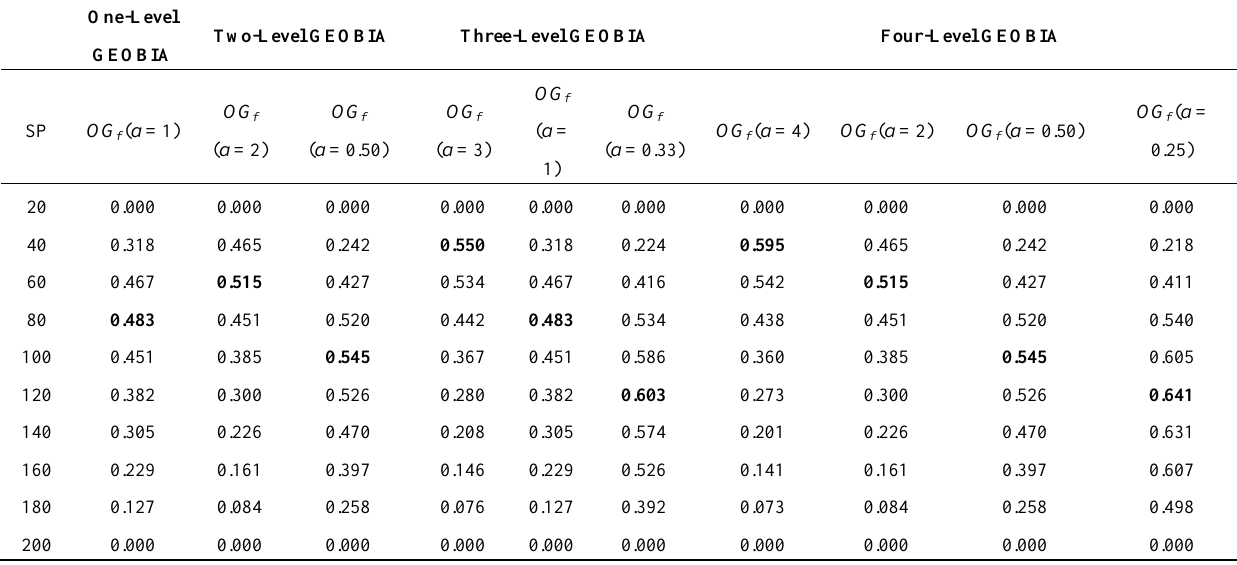
Table 3. OG f values of each segmentation level. Bold values show the segmentation level with the highest goodness for each a value ( i.e. , the values reported in Table 1).